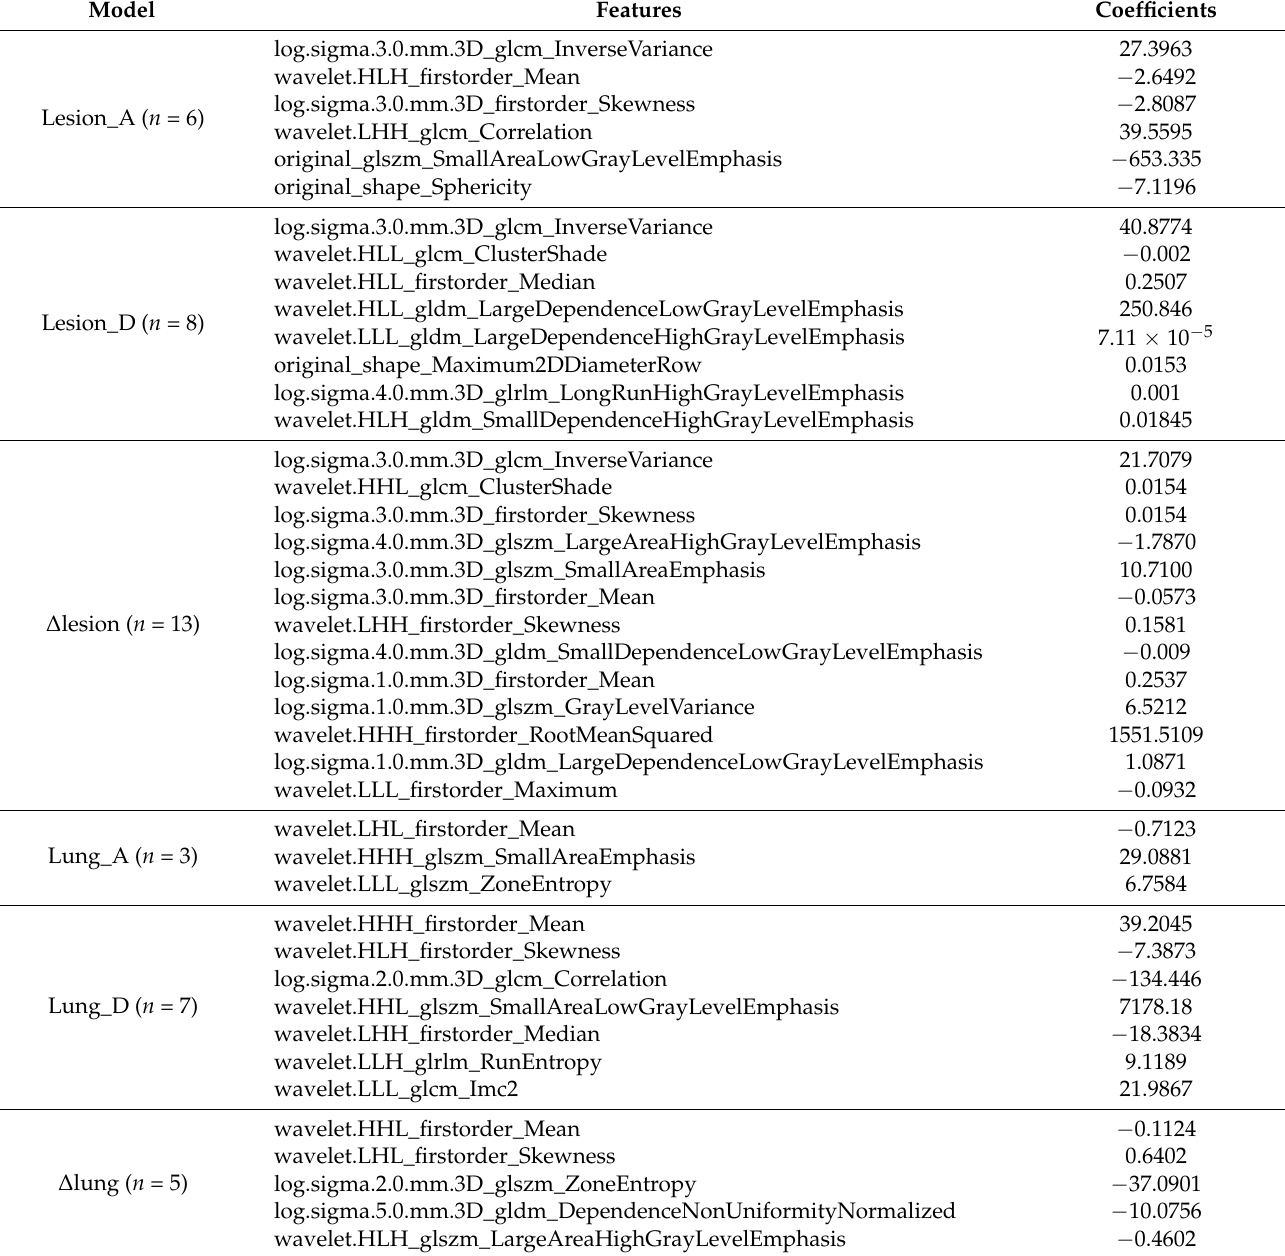
Table 2. Radiomic feature selection results of the six